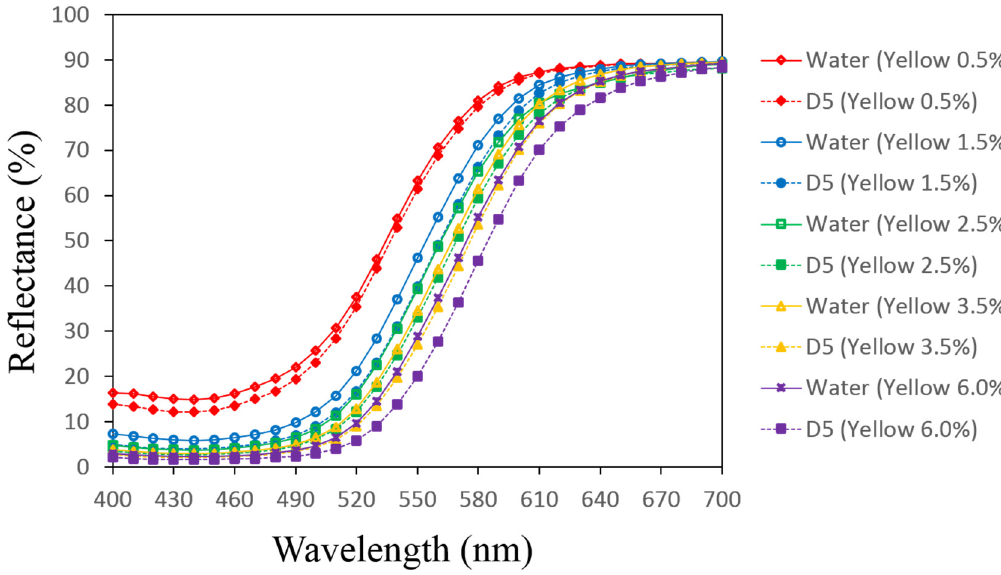
Figure 4. Reflectance curves of the yellow color of batch samples dyed in water and D5 medium.